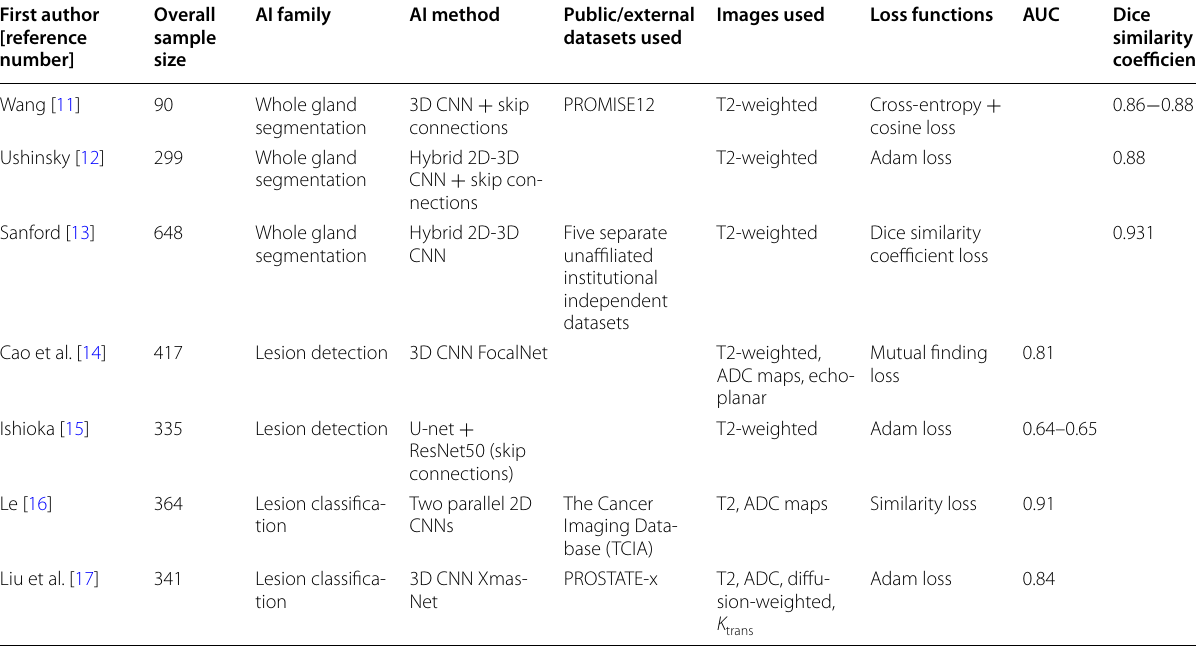
2D Two-dimensional, 3D Three-dimensional, ADC Apparent diffusion coefficient, AUC Area under the curve, CNN Convolutional neural